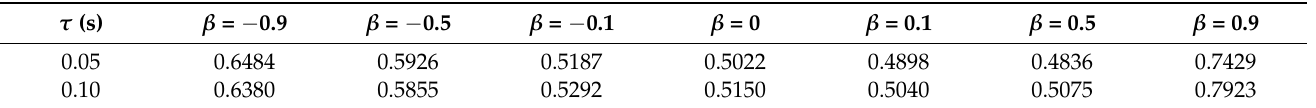
Table 9. Root mean squared value of the control signal 𝑢 (cid:2869) in the first 30 s under different input time delays and different fractional orders in the proposed controller.